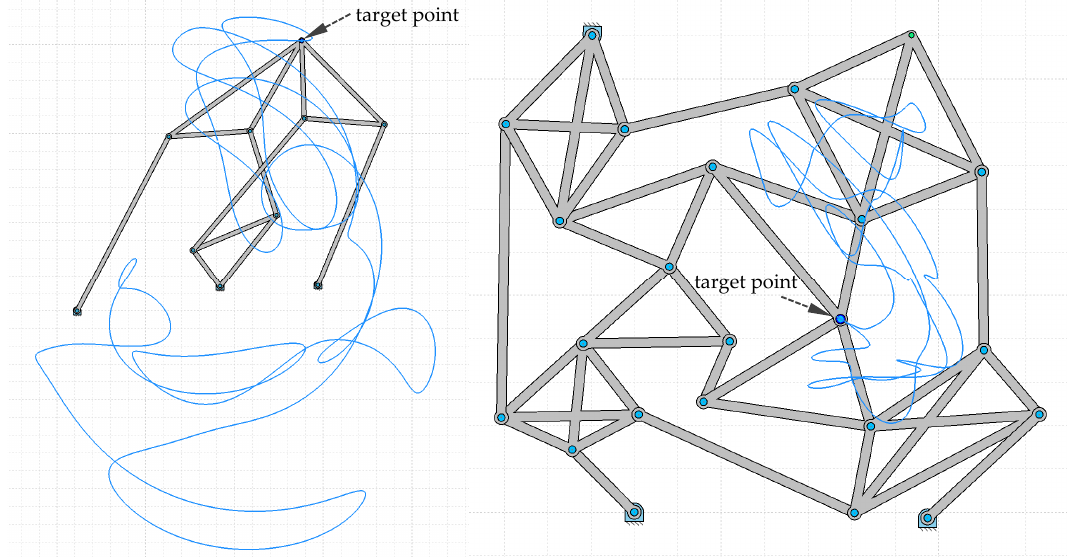
Figure 11. Complex trajectories of one degree-of-freedom mechanisms computed automatically (see Videos S1 and S2 of the Supplementary Material to visualize the motions of both mechanisms).